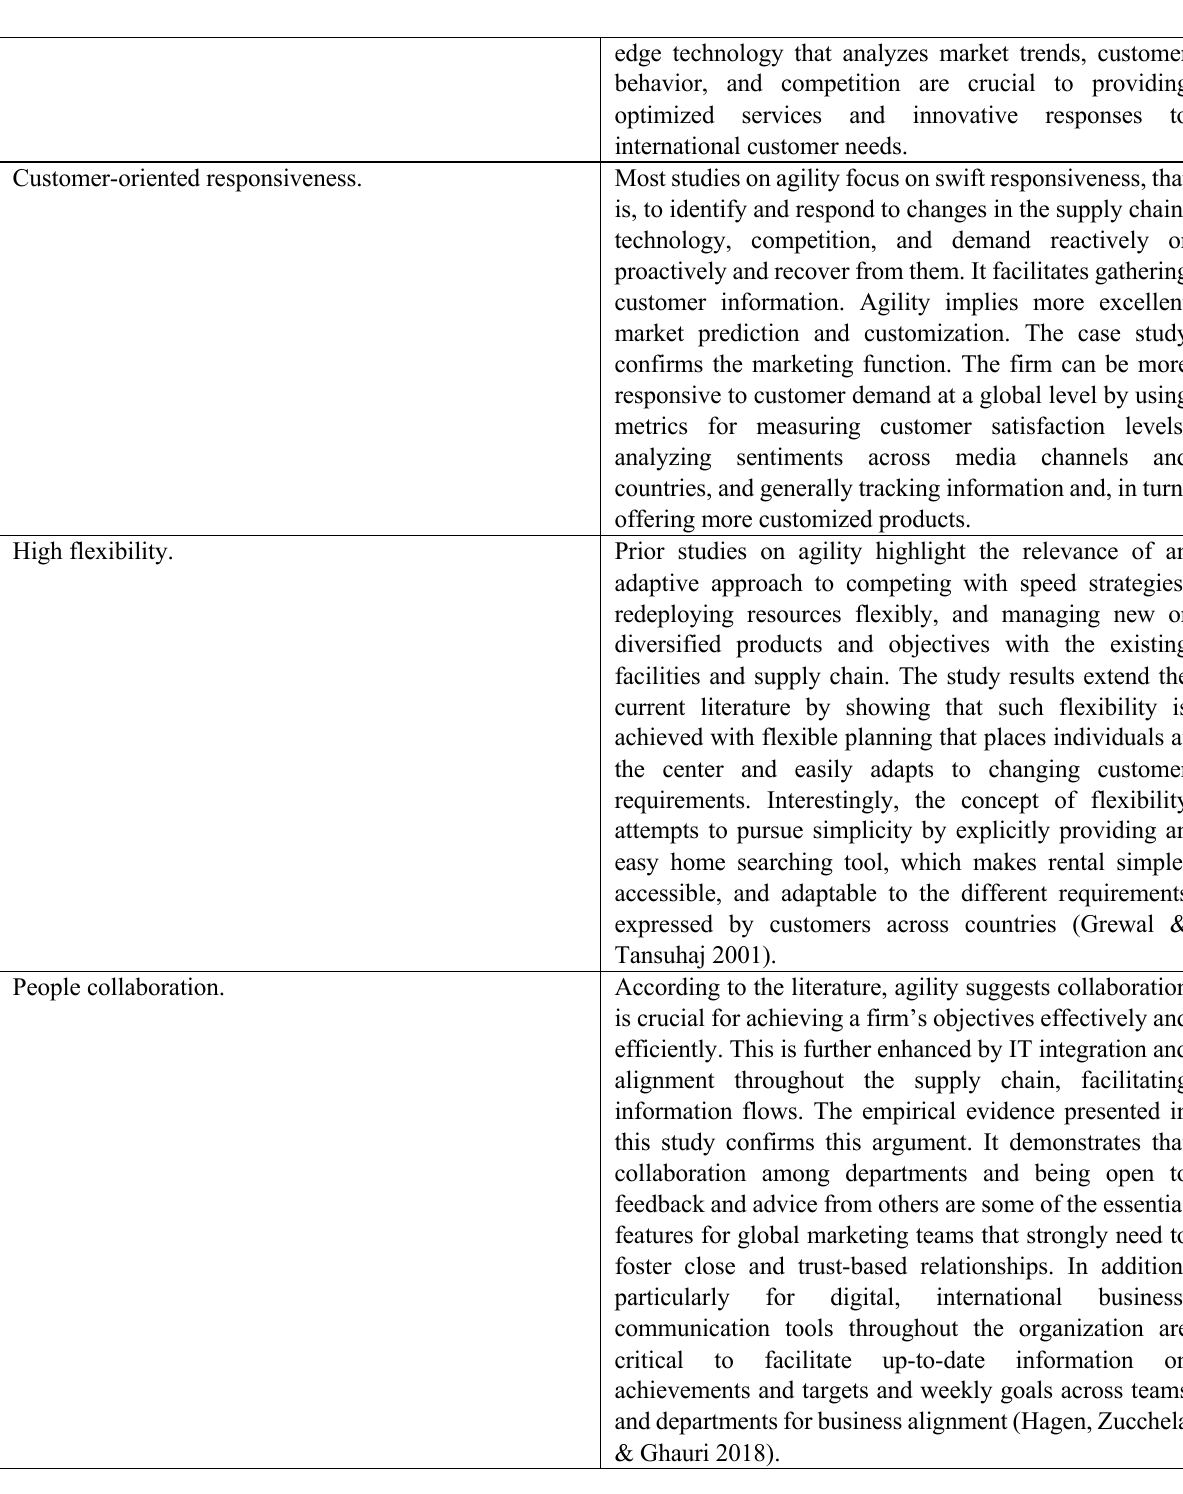
Table 4. Agile Marketing Capabilities Assertions of European Shadow Bank